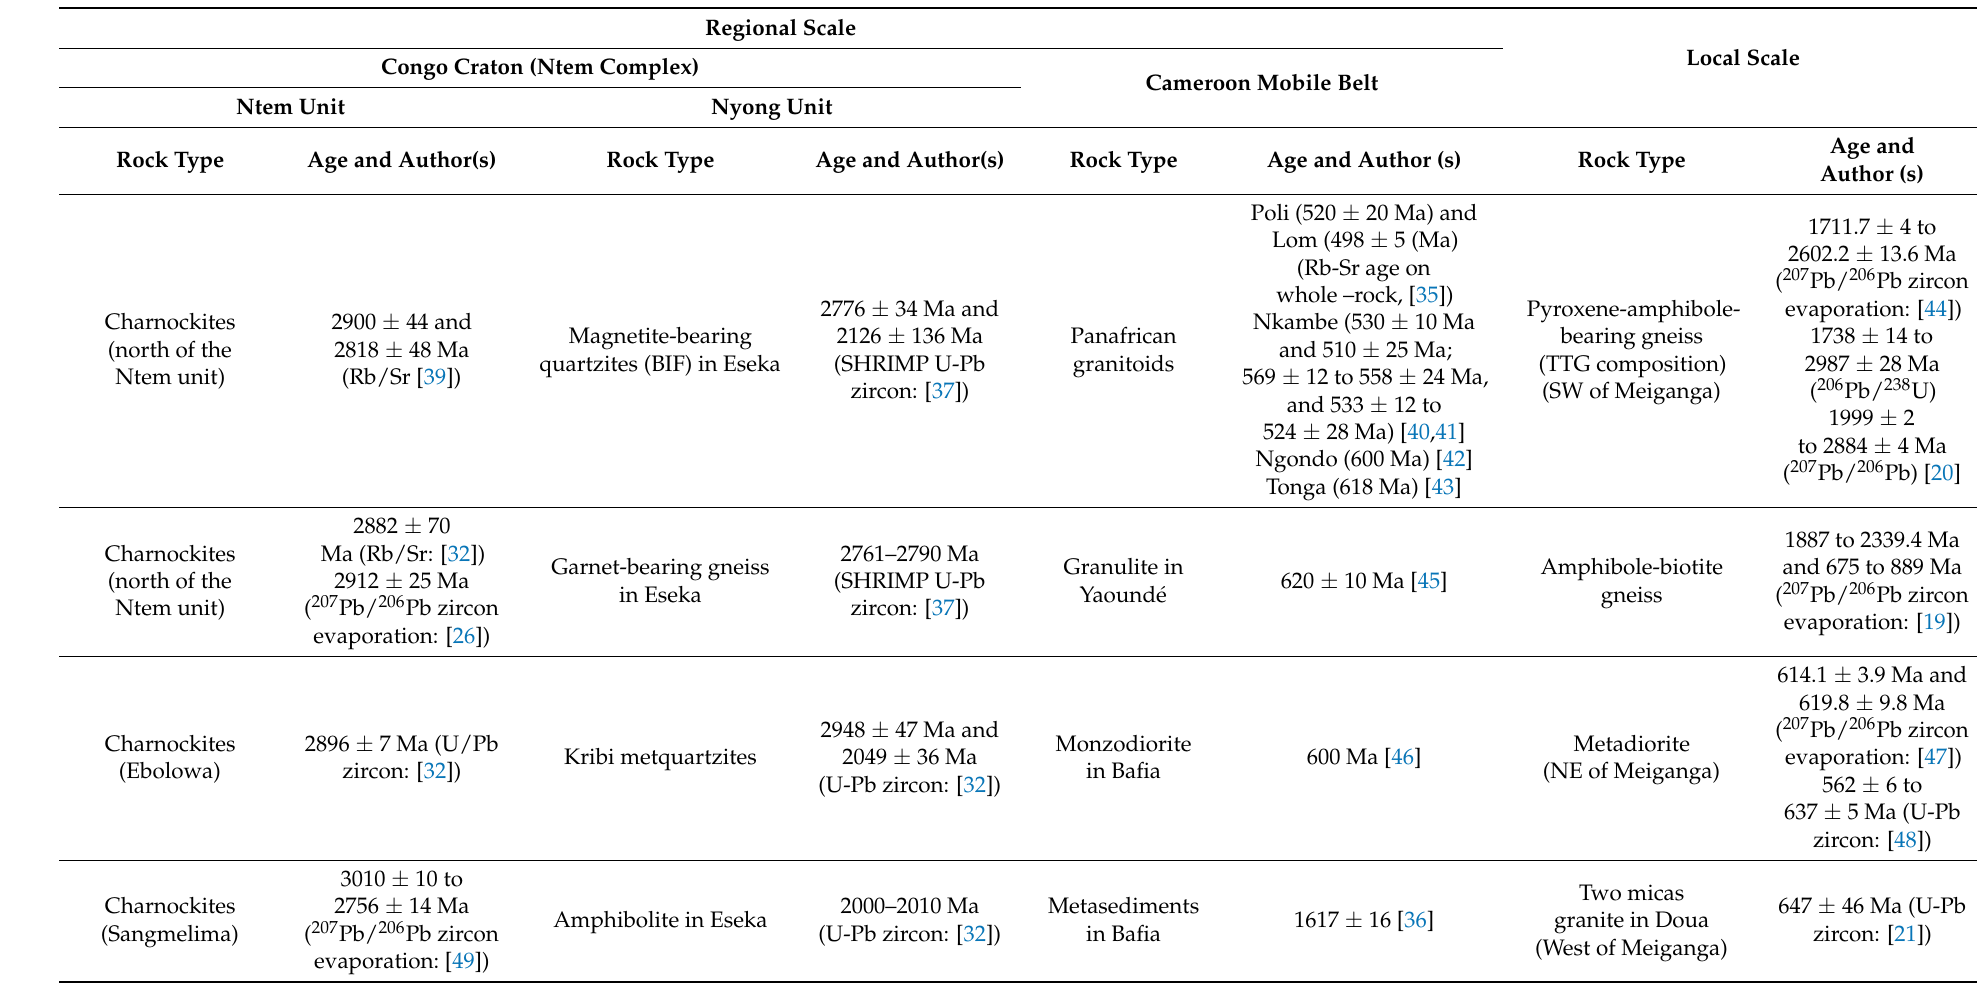
Table 1. Summarized ages of plutonic and metamorphic rocks found in Congo Craton, Cameroon mobile belt, and